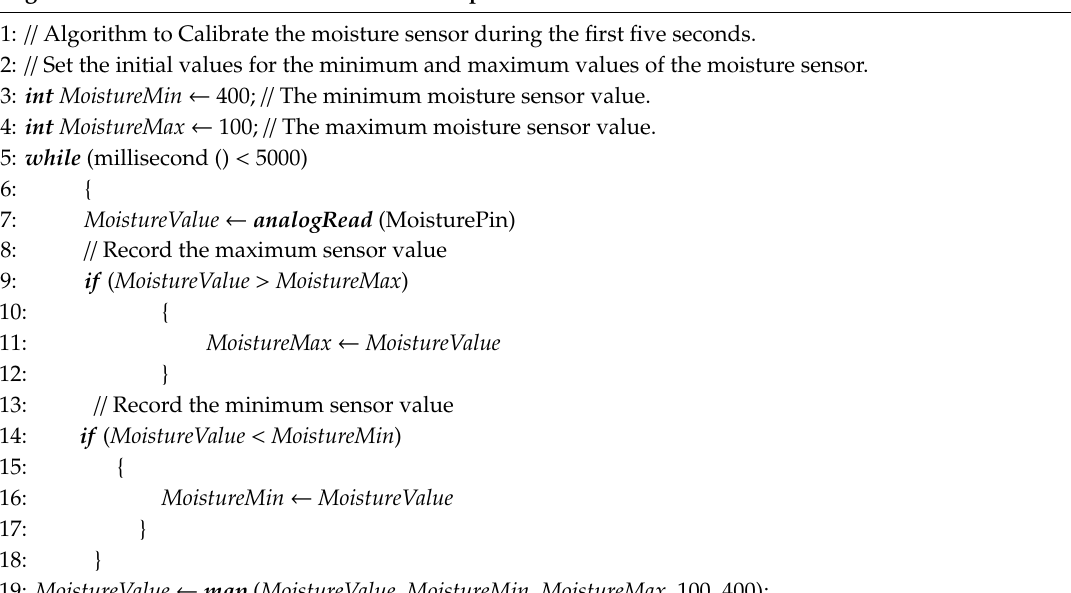
Algorithm 1: Soil moisture sensor calibration